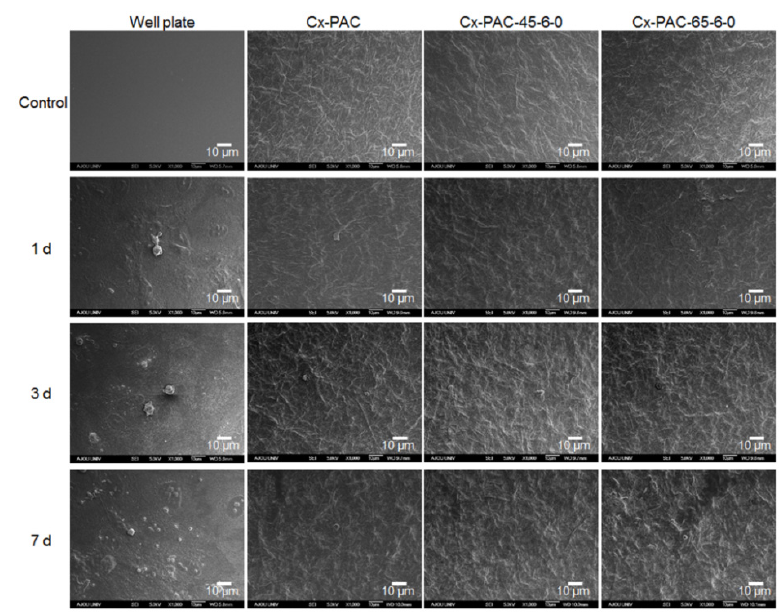
Figure 6. SEM micrographs showing no cell (control) and HUVECs cultured for one to seven days on plate and Cx ‐ PAC film after thermal treatment at 45 °C and 65 °C. Magnification: 1000× and scale bar represents 10 µ m.